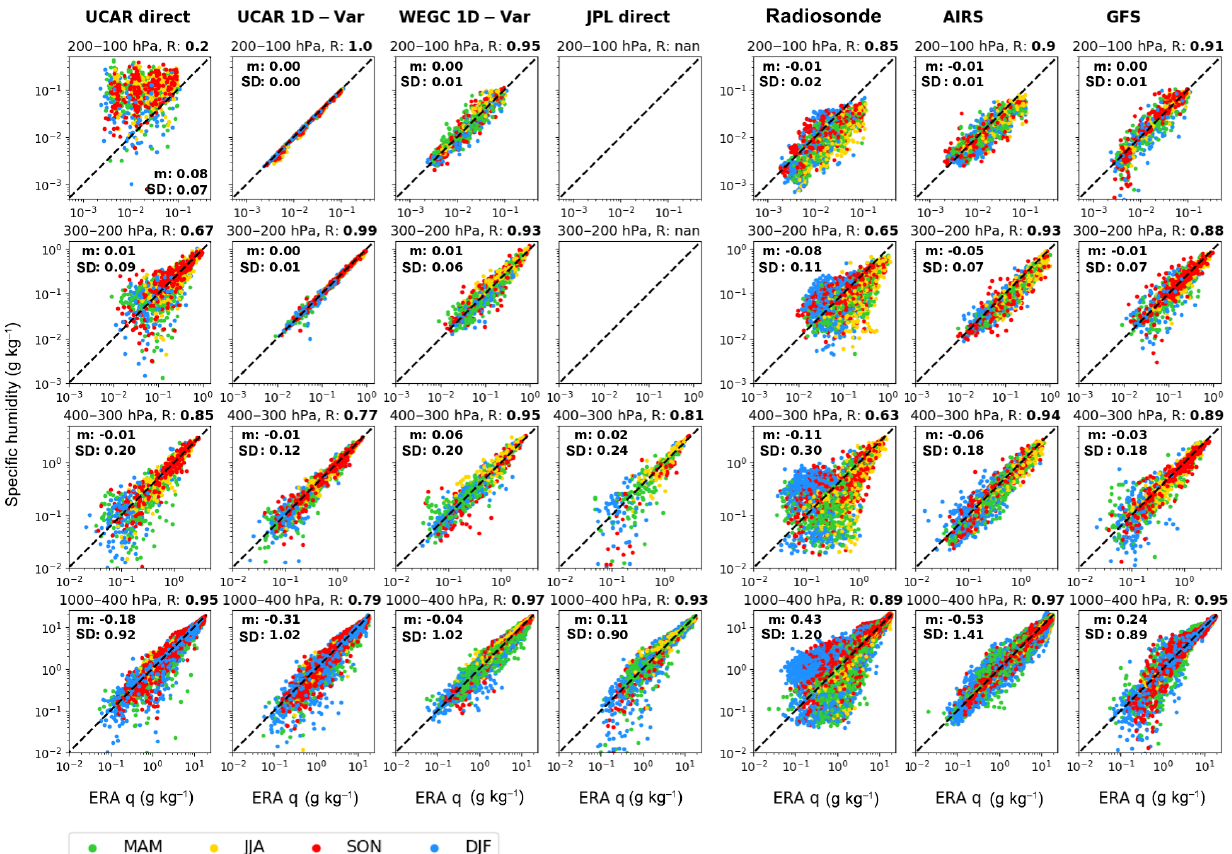
Figure 2. Guam: scatterplots of q for seven data sets versus ERA for four pressure layers. Left to right: UCAR direct, UCAR 1D-Var, WEGC 1D-Var, JPL direct, RS, and AIRS. Correlation coefficients as well as mean and standard deviation of the differences are given for each panel. Note that both axes are on a logarithmic scale and that axis limits vary for different pressure